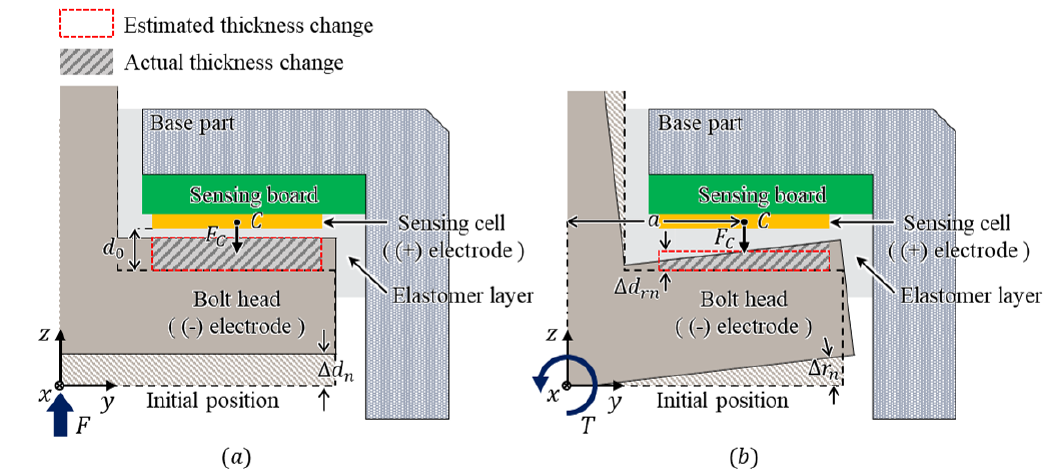
Figure 3. Cross-sectional view of the sensing structure of the proposed sensor. ( a ) Displacement by applied force. ( b ) Dis- placement by applied